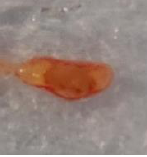
Figure 3. MagUS SLN-biopsy specimen (size 1 cm).